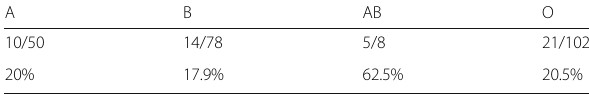
Table 2 (abstract 0184). The Platelet count below